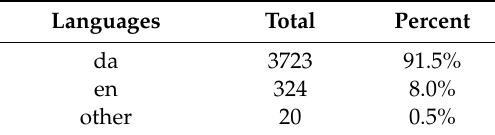
Table A13. Primary languages (dk).